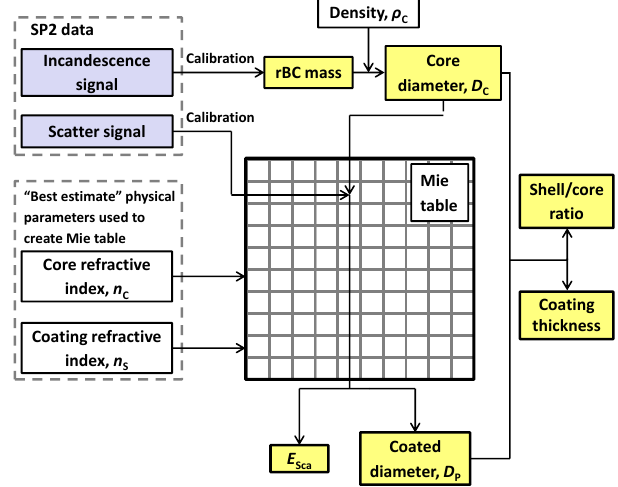
Figure 2. Overview of the input data/parameters and steps involved in calculating coating properties using SP2 data. Blue boxes repre- sent the raw measured data, white boxes represent assumed param- eters, and yellow boxes represent derived